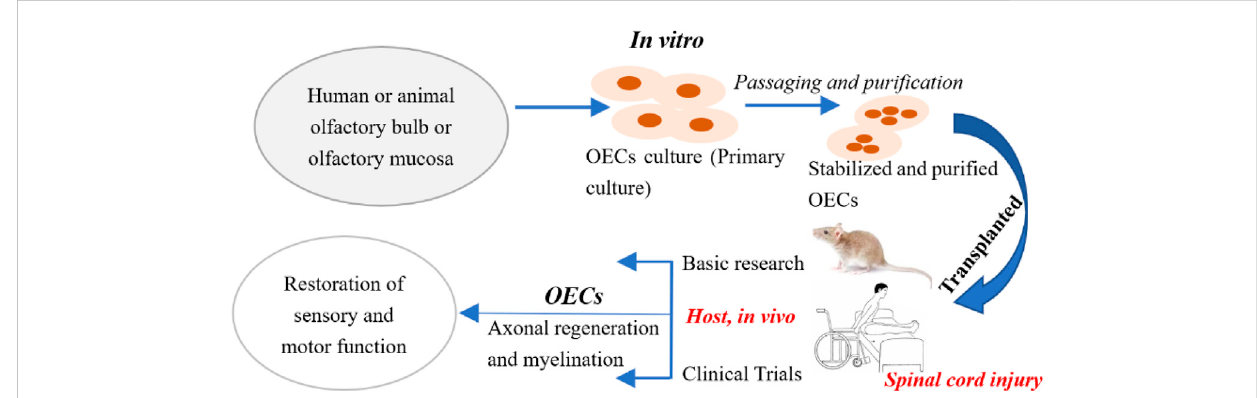
Procedure for OECs transplantation of the treatment for spinal cord injury. Step 1: Take olfactory bulb tissue or olfactory mucosa from animals or humans; Step 2: Pay attention to aseptic operation throughout the process, and in vitro primary culture OECs; Step 3: Purify and identify the cultured OECs to obtain stable OECs; Step 4: Transplant the stably cultured OECs into the host; Step 5: Check the host ’ s sensory and functional recovery after OECs